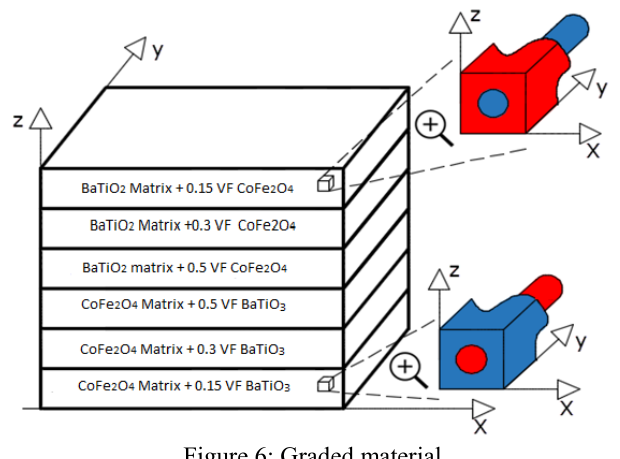
Figure 6: Graded material